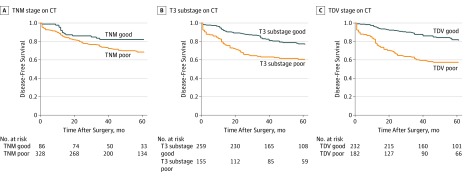
Kaplan-Meier Curves for Tumor Recurrence Using Different Staging SystemsCT indicates computed tomography; TDV, tumor deposits and extramural venous invasion.